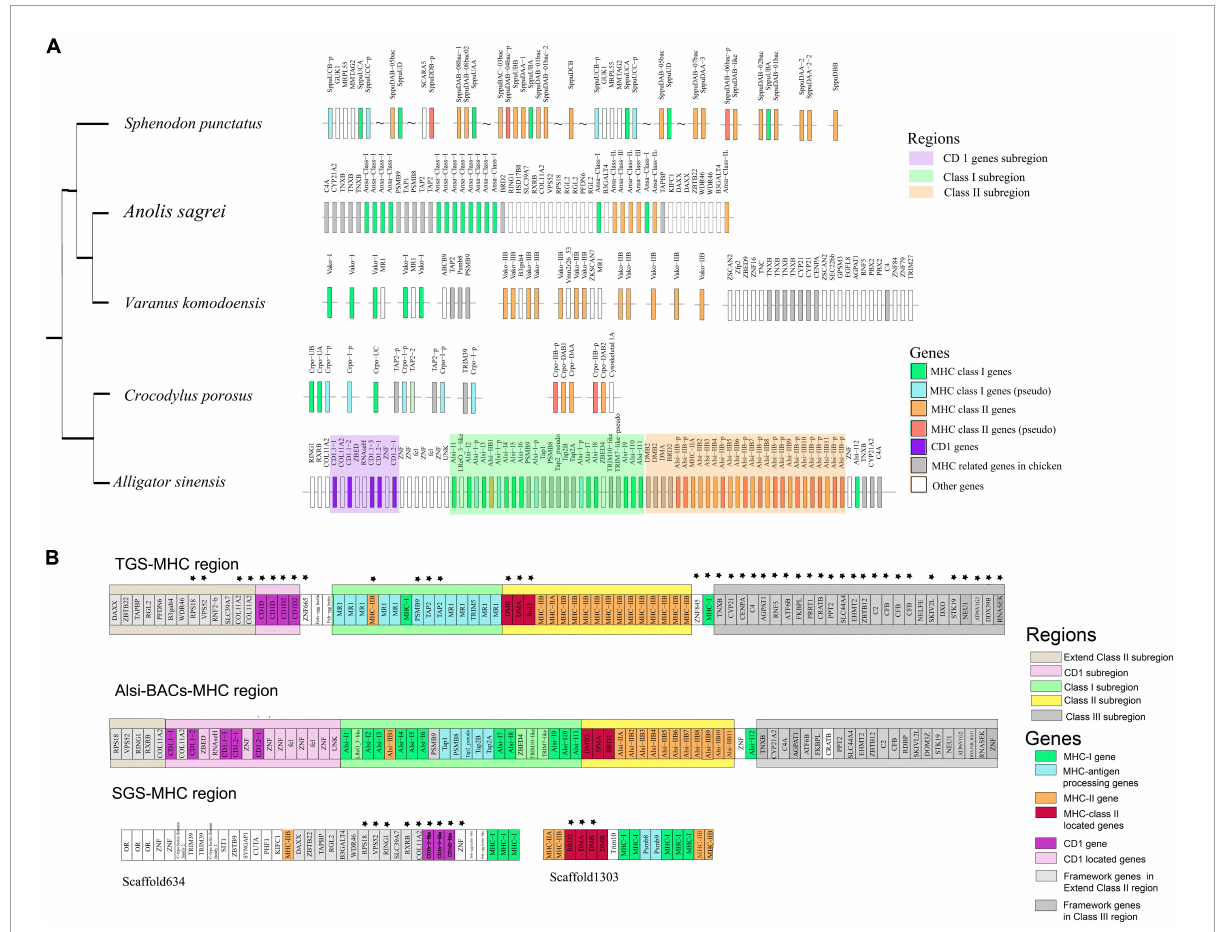
FIGURE3 (A) Gene arrangement in the Chinese alligator and other published MHC regions of reptiles. In Sphenodon punctatus , wavy lines suggest existence on the same chromosome but with uncertain distance. Molecular distances between genes and subregions are not reflected on the map. (B) The comparison of gene annotation in the SGS-based genome, gene prediction in Alsi-BAC-MHC region, and gene annotation in TGS-based genome. The genes having a conserved location with the Alsi-BAC-MHC region (except MHC-I and MHC-II genes) are marked with